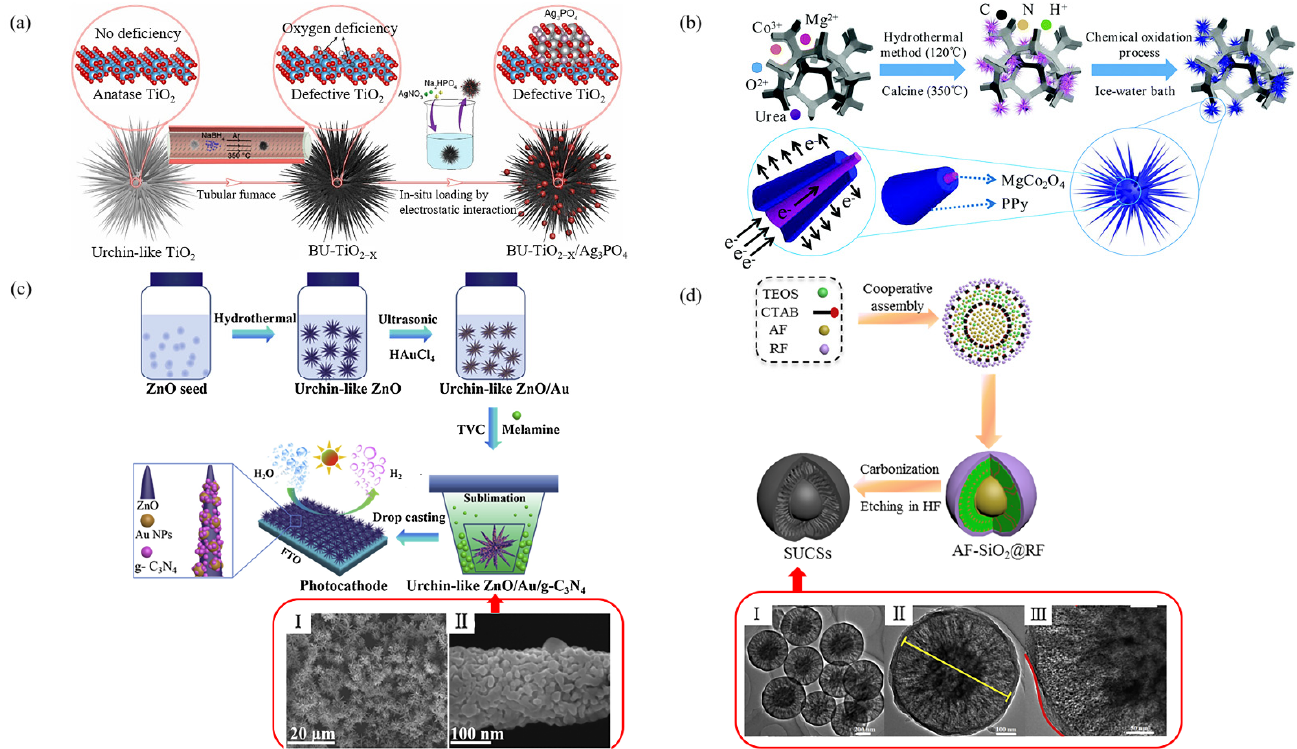
Figure 4. Examples of different composite types of sea urchin-like composite micro-/nanoparticles: ( a ) The synthesis process of BU-TiO 2–X /Ag 3 PO 4 [67] (Reprinted with permission from ref. [67]. Copyright 2021 Elsevier). ( b ) Schematic diagram of the synthesis process and electron transfer of MgCo 2 O 4 @PPy/NF [68] (Reprinted with permission from ref. [68]. Copyright 2018 The Royal Society of Chemistry). ( c ) Schematic diagram of the fabrication processes of the urchin-like ZnO/Au/g-C 3 N 4 photocathode and the low-magnification (I) and high-magnification (II) SEM images of urchin-like ZnO/Au/g-C 3 N 4 [69] (Reprinted with permission from ref. [69]. Copyright 2019 Elsevier). ( d ) Illustration of the fabrication of the SUCSs via one-pot cooperative assembly strategy and TEM images of SUCSs with different amount of RF resins; SUCSs-R-0.2 (I–III) [70] (Reprinted with permission from ref [70]. Copyright 2017 Elsevier).